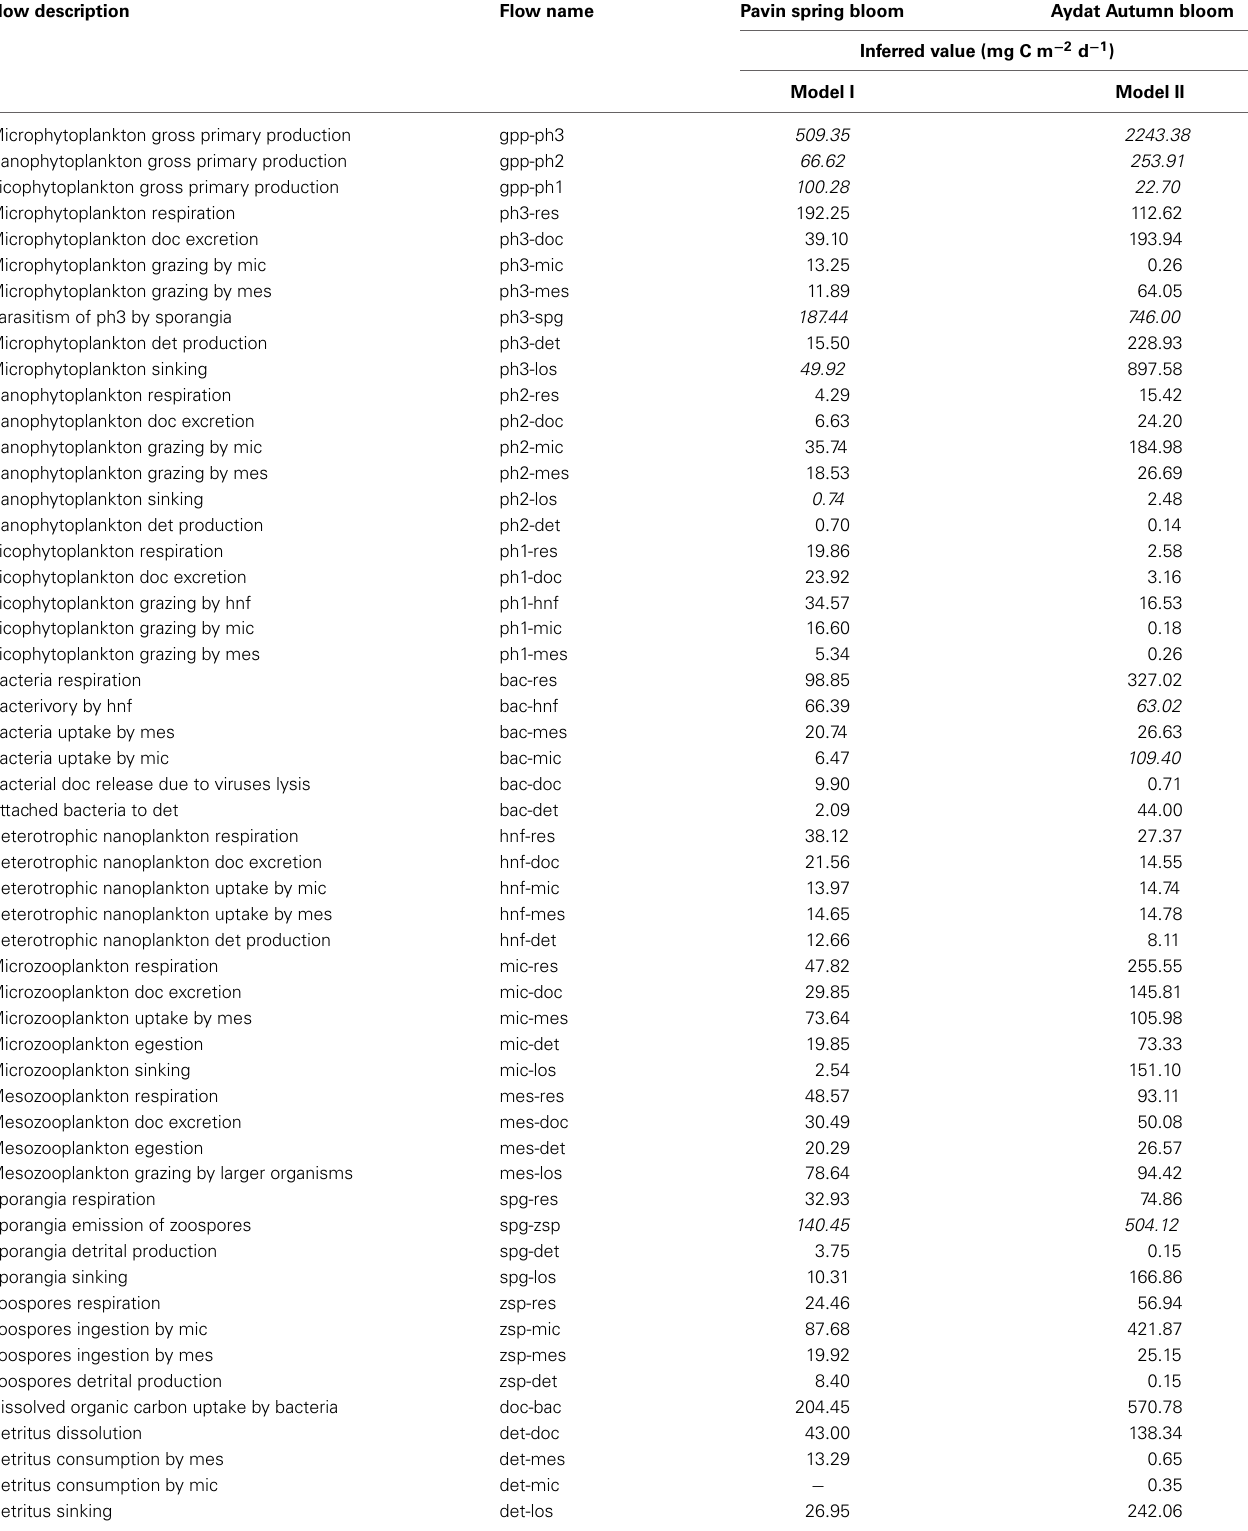
Table 3 | Flow description, name and corresponding value (mg C m − 2 d − 1 ) of steady state models of the pelagic food web of Lake Pavin and Lake Aydat during each lake bloom